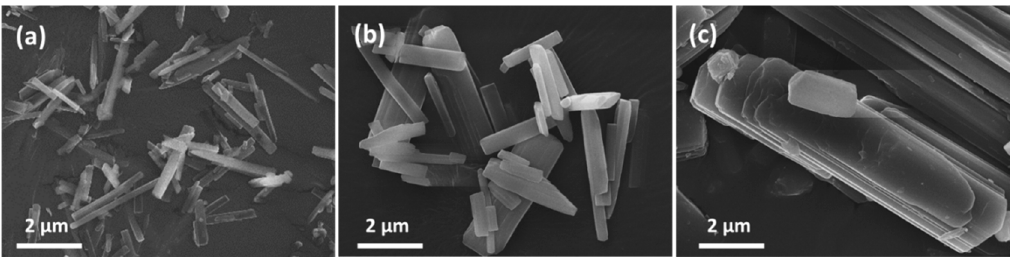
Figure 4. SEM images of different CH 3 COOH concentrations. ( a ) Ca-MOF-24h-10 ( b ) Ca-MOF-24h-5 and ( c ) Ca-MOF-24h-1.